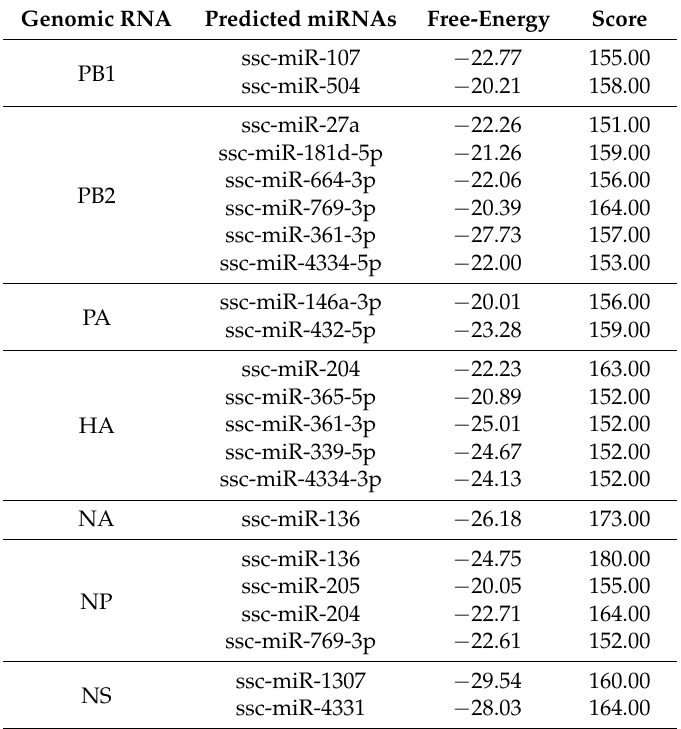
Table 1. Potential microRNAs (miRNAs) targeting the SIV-H1N1/2009 genomic RNA predicted